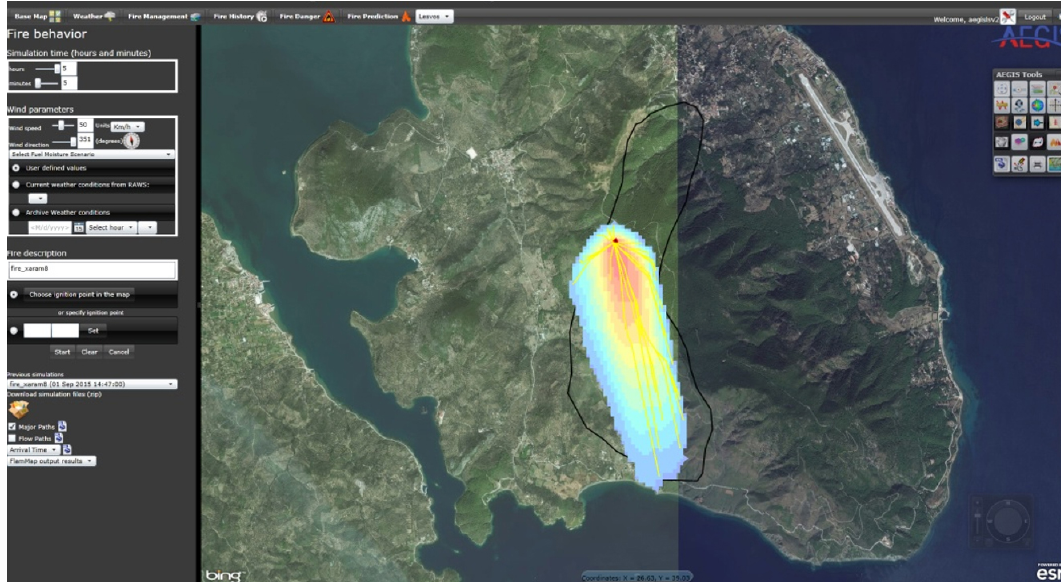
Figure 11. Second simulation run of Lesvos 2015 wildfire from the site where the first simulation ended (Fig. 9f). Black polygon delimits the actually burned area, while the colored area and lines map times of arrival and major travel paths in AEGIS.